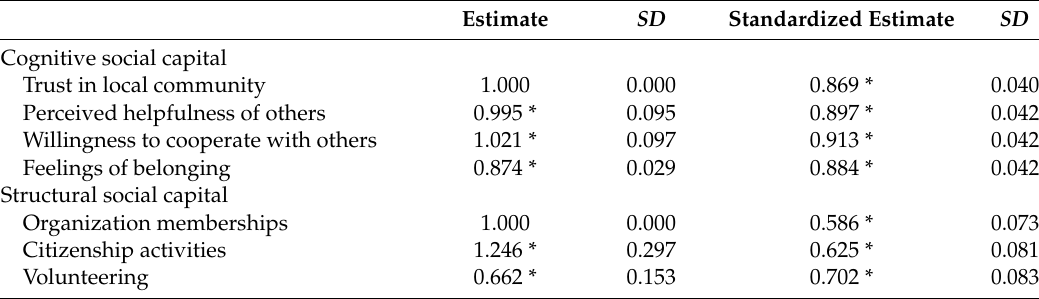
Table 2. Measurement Model of Cognitive Social Capital and Structural Social Capital.